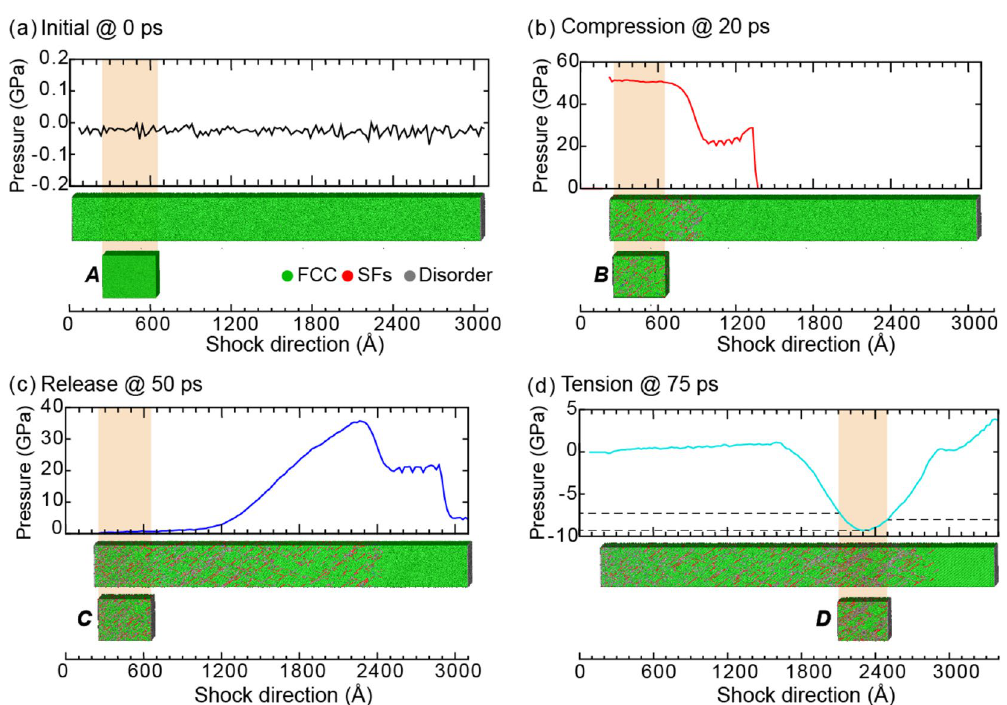
Figure 8. The pressure distribution and microstructure for select time steps of shocked Cu. Cropped regions to be assessed with virtual diffraction are highlighted in tan. The cropped regions, labeled A–D, correspond to the blue rectangles in Fig.